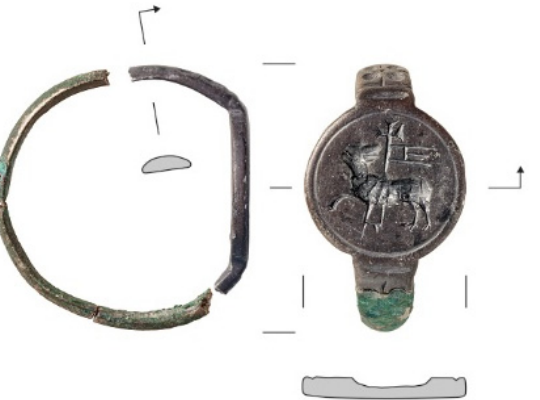
Figure 11. Treasure from Wiener Neustadt. Finger ring with “Agnus Dei” motif, 1st half of 14th century. Photo: Paul Kolp; editing: Franz Siegmeth.